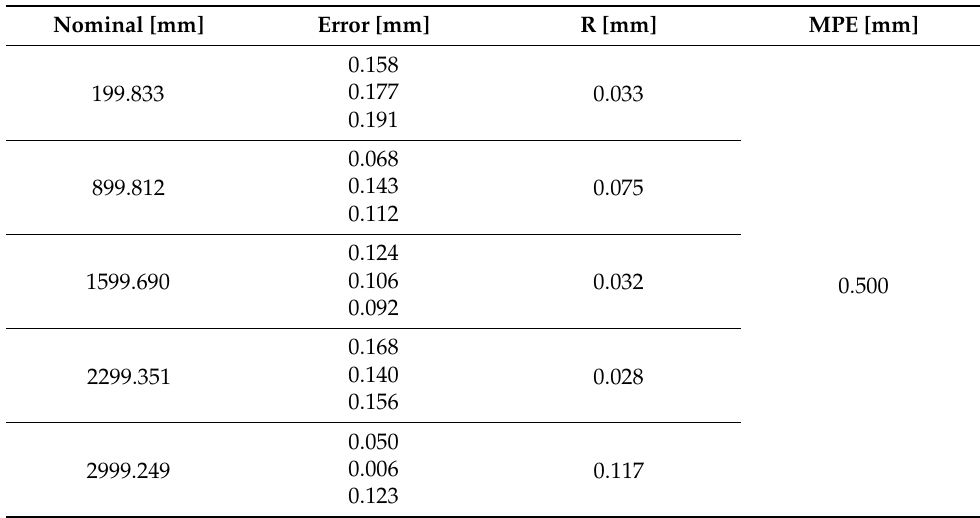
Table 4. Measurement errors of the XZ1 axis.